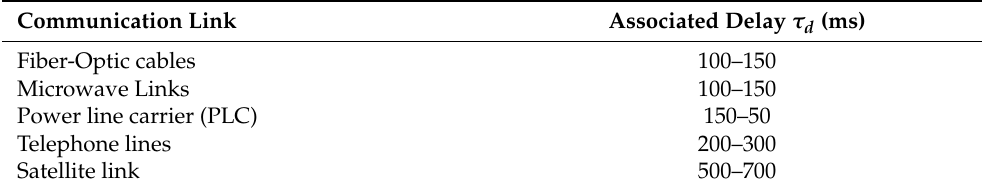
Table 1. Ranges of Latencies in Communications [40].